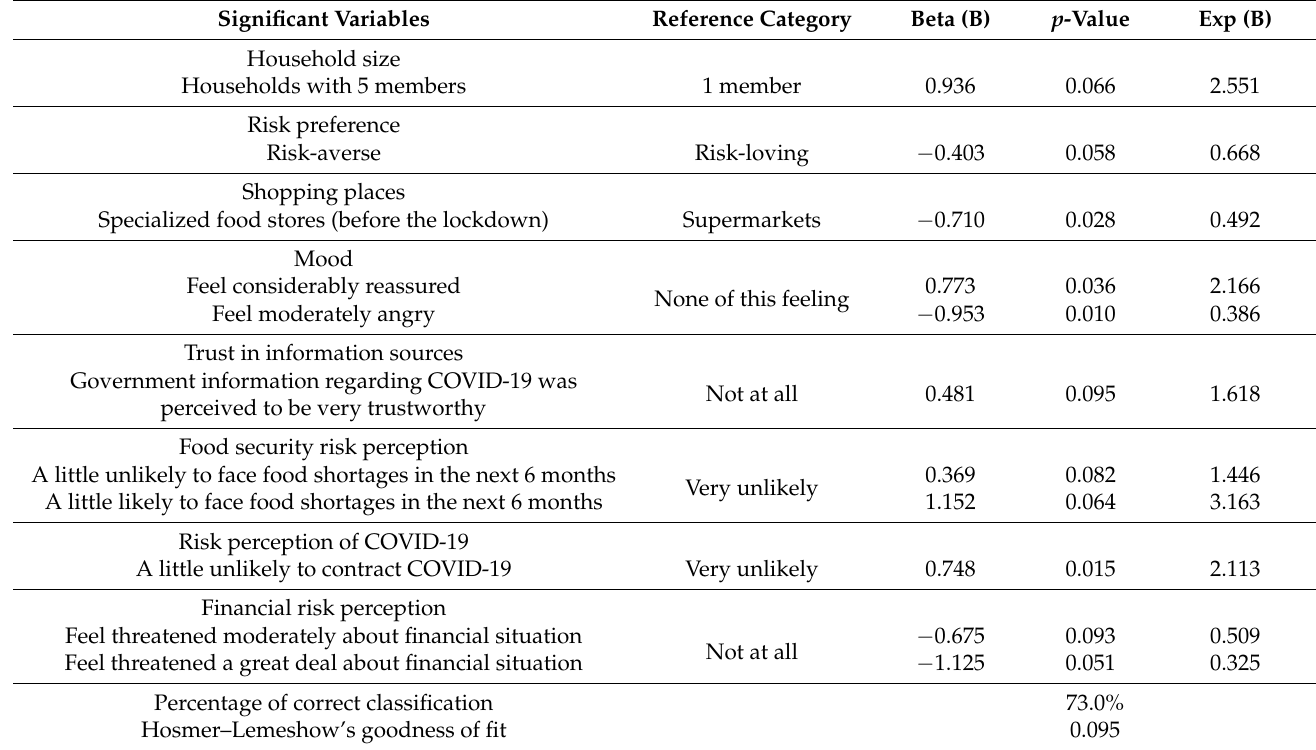
Table 6. Logit model of purchasing food with sustainable attributes (S)